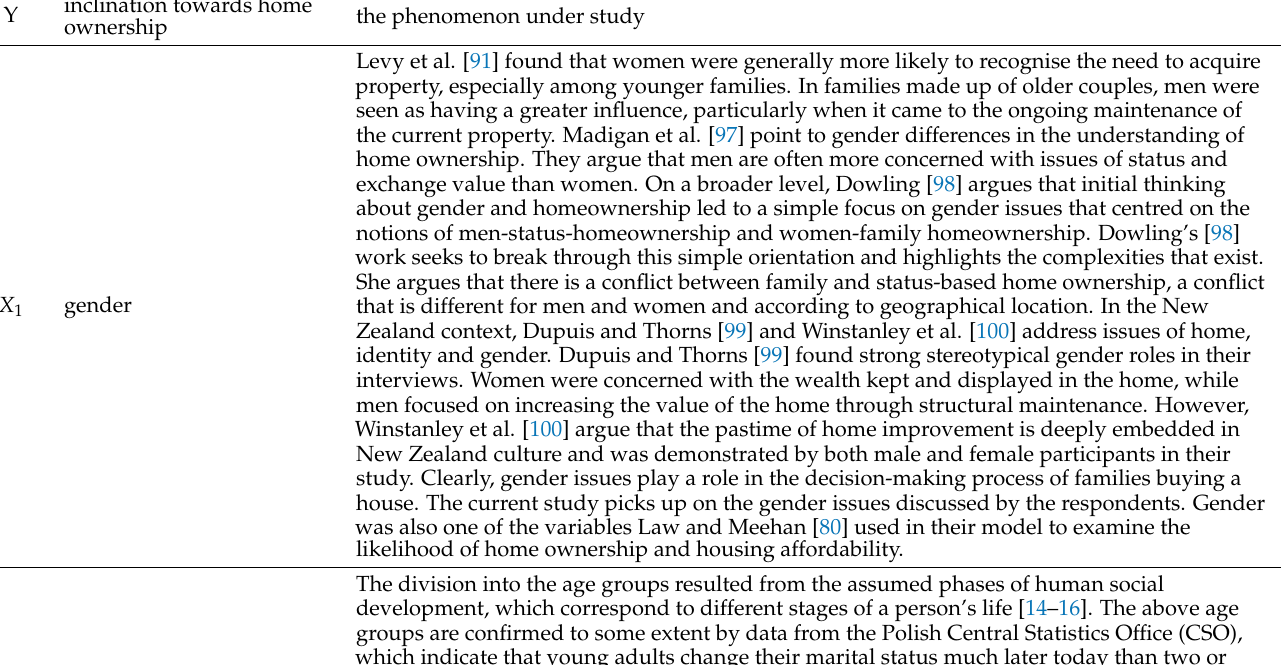
Table A1. List of variables used in the analysis and their relevance in the context the logistic regression model. Var Variable Reason inclination towards home Y the phenomenon under study ownership